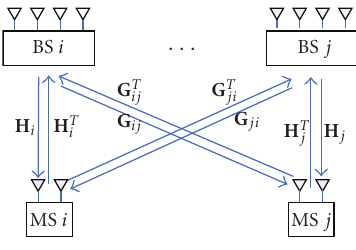
Figure 3: BFaN system